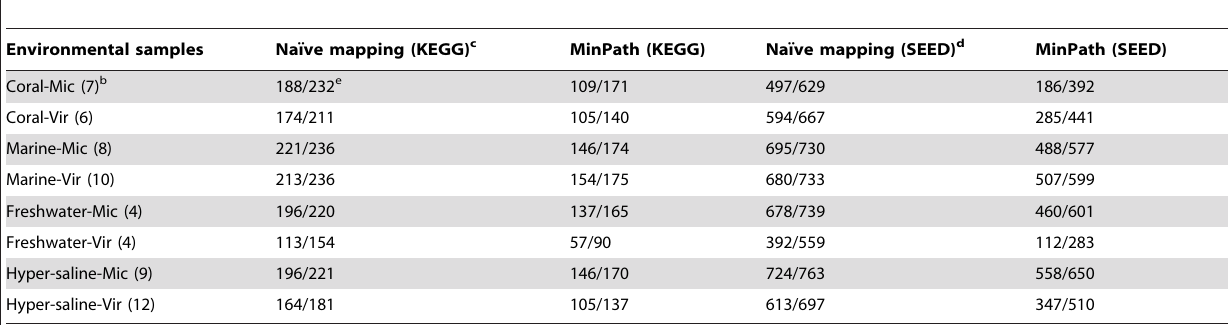
Table 3. Comparison of biological pathway reconstruction based on MinPath and the naı¨ve mapping approach for selected metagenomes a